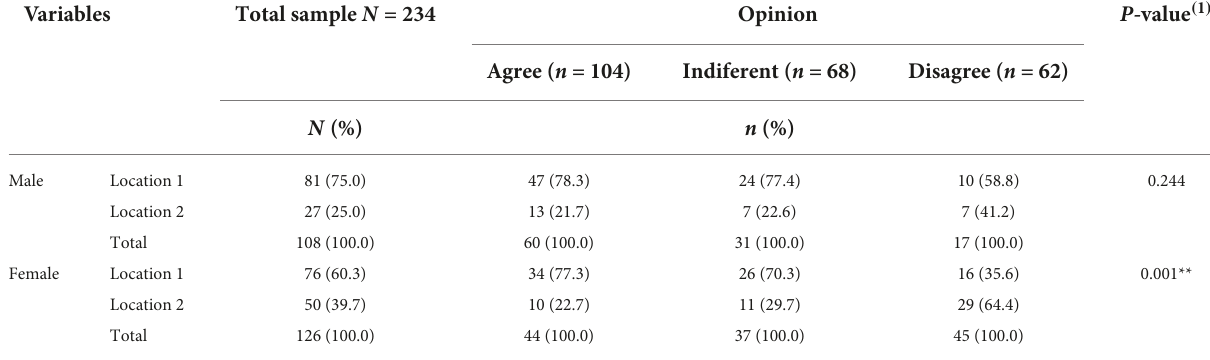
TABLE 3 Crossover between variables sex, location and opinion on the reduction of